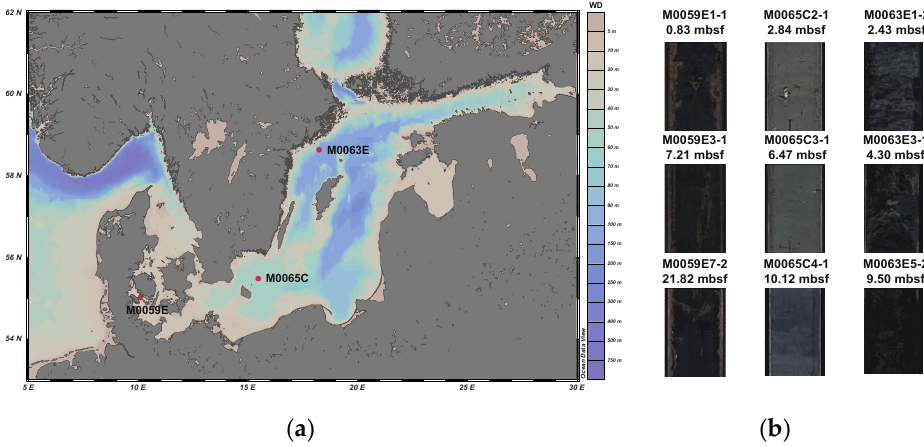
Figure 1. ( a ) Coring sites of the IODP drilling expedition 347 with the specific holes sampled. ( b ) The picture of the neighbor section of sediment samples used in this study. WD: water depth, mbsf: meters below seafloor.